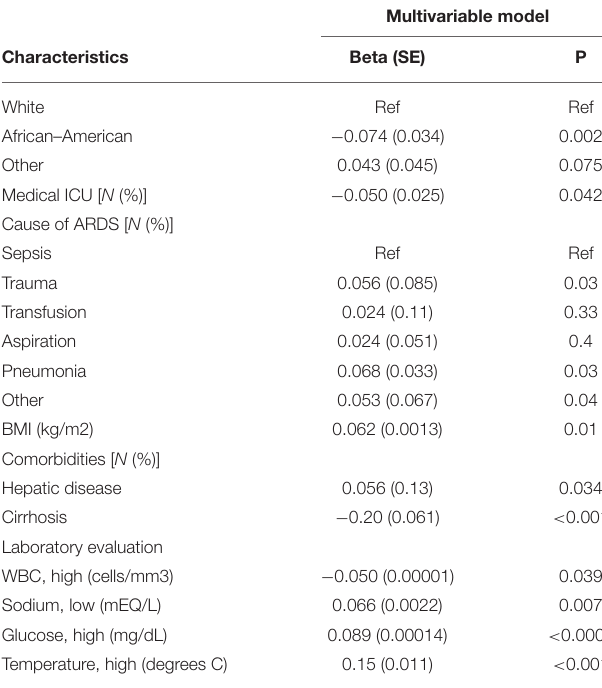
TABLE 3 | Multivariable regression table for factors associated with PCSK9 level in